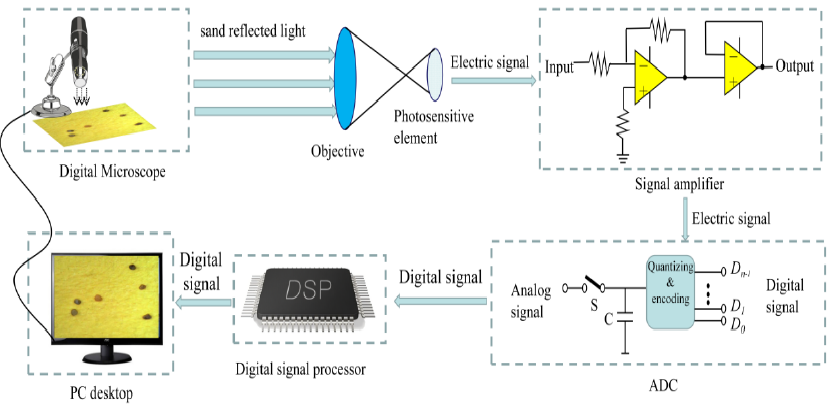
Figure 6. A diagram of a camera system.